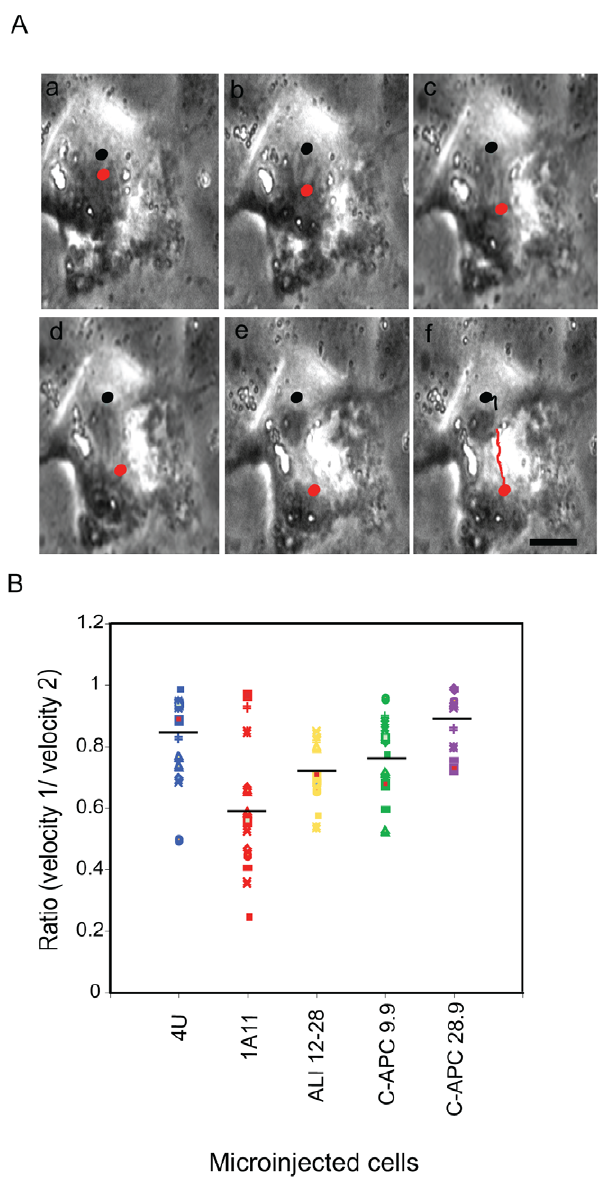
Figure 7. Microinjection of 1A11 induces asymmetric spindle pole movement. A: Stills (a–f) taken from a recording of a representative cell microinjected with 1A11. As shown by the tracks, one set of chromosomes (the black spot closest to the top of the frame) remains relatively static within the cell during anaphase B and telophase while the other moves. The black and red tracks indicate chromosomal movement. Scale bar=10 m M. B: Velocities were ob- tained for anaphase chromosomal movement in microinjected cells and used to derive a ratio that reflected any asymmetry in the observed movements, with values close to 1 representing symmetrical chromo- somal separation. A plot showing the range of velocity ratios obtained is shown. Only cells injected with the EB1 specific antibody 1A11 displayed an asymmetry in movement that generated a ratio of less than 0.5 (column 2). (4 U, n=14; 1A11, n=14; ALI 12–28, n=10, C-APC 9.9, n=12; C-APC 28.9, n=9). Black line indicates mean value.